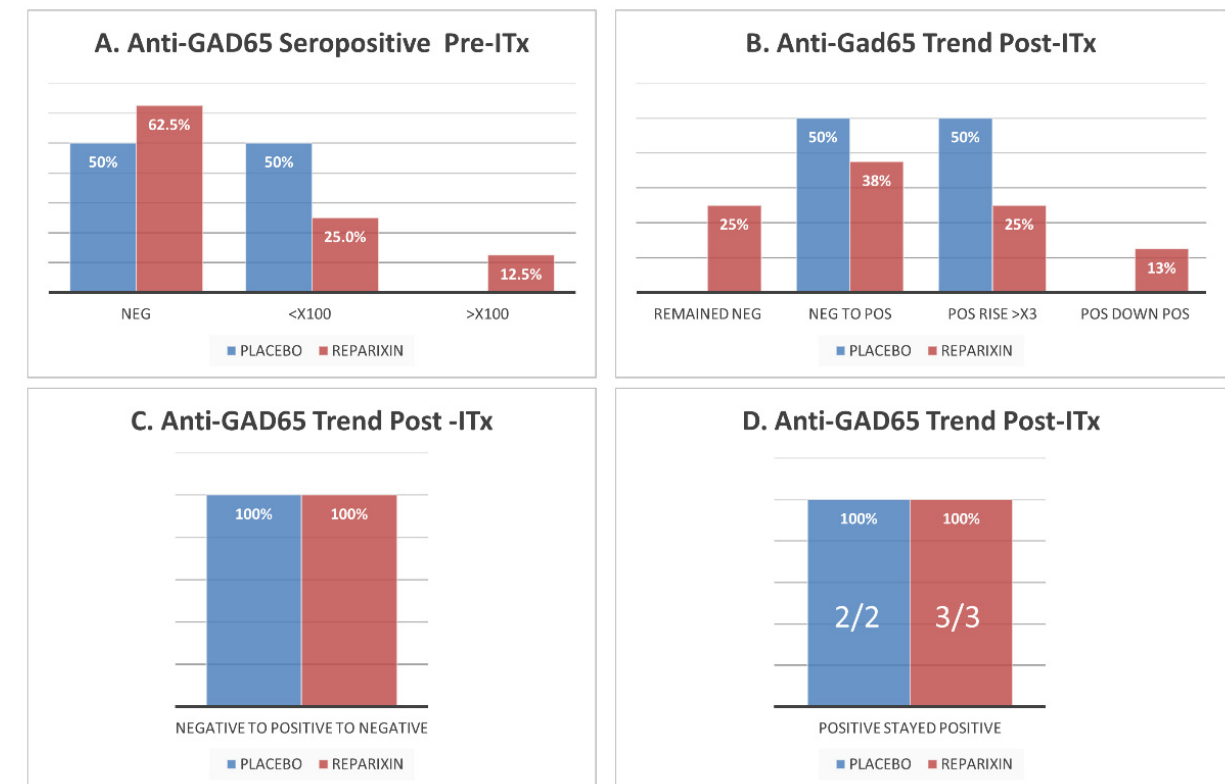
Figure 1. GADA seropositivity of islet transplant (IT) recipients pre- and post-IT in Reparixin vs. placebo group. ( A ) GADA seropositivity of islet recipients prior to IT. Most of the patients were GADA negative prior to IT in both groups. ( B ) Trend of GADA expression after IT in relation to pre-IT. Most patients developed or increased their titers of GADA in both groups. Persistence of GADA after IT: All patients who were GADA negative pre-IT, developed GADA after IT, but cleared them within 6 months. ( C ). All patients who were GADA positive pre-IT remained seropositive after IT ( D ). ITx, islet